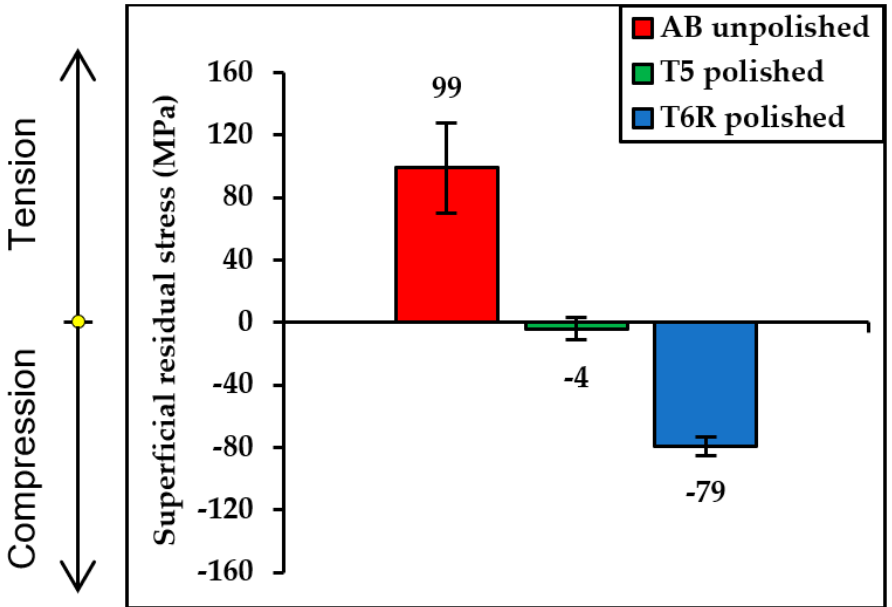
Figure 4. Comparison of residual stress σ Res measured on the AB unpolished surface and T5 and T6R polished surfaces.